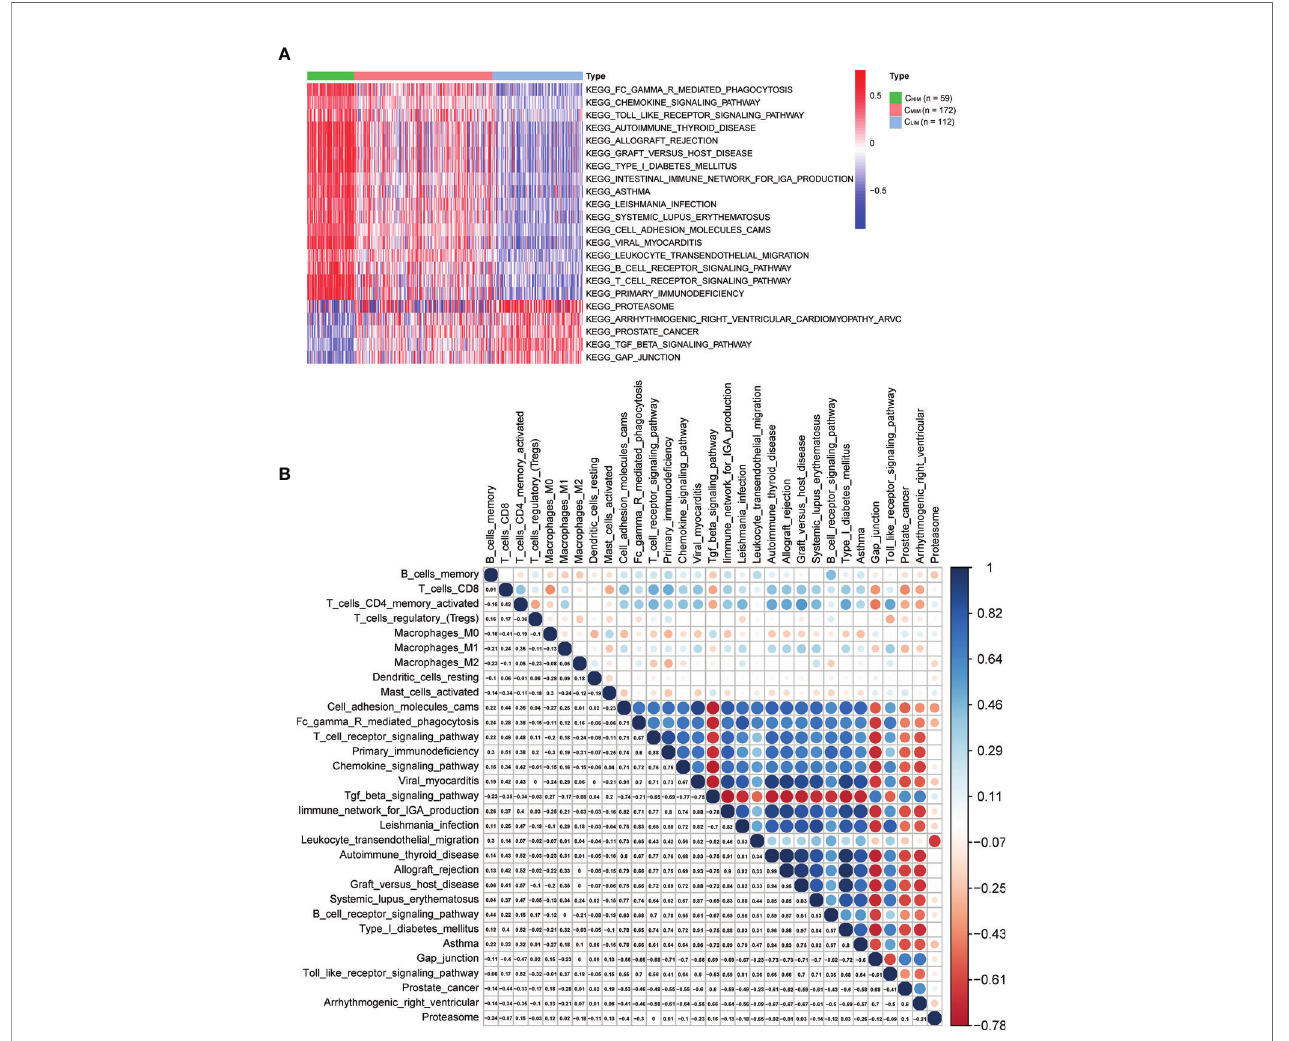
FIGURE 6 | Differential pathways in immune-based subtypes and their correlation with in fi ltrated immune cells. (A) KEGG pathway enrichment was identi fi ed by GSVA in three subtypes. Only pathways with signi fi cant differences are listed. (B) Correlations among these KEGG pathways and in fi ltrated immune cells in gastric cancer